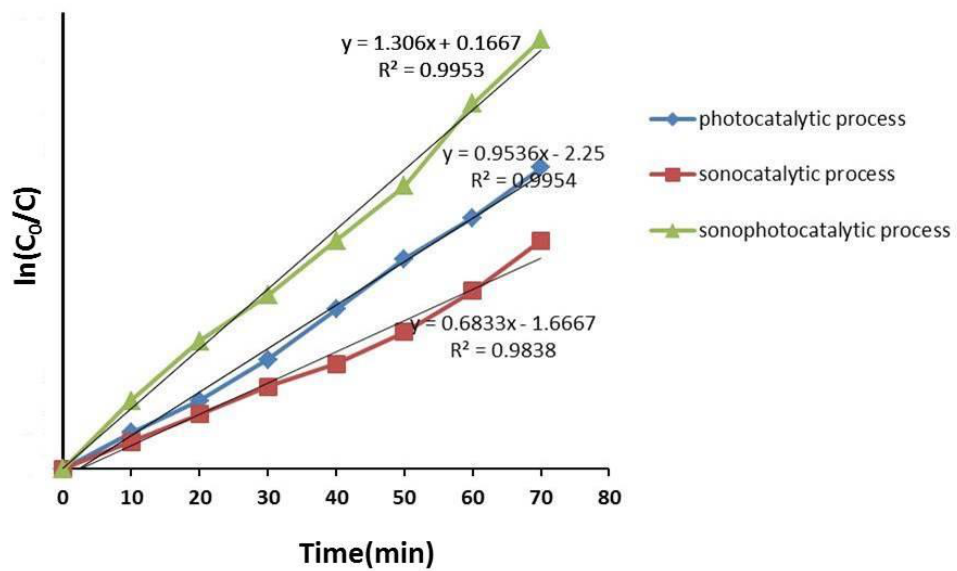
Figure 8. First-order kinetic plot for sono-photocatalytic, sonocatalytic and photocatalytic processes. [Dye] = 20 mg/L, [Catalyst] = 1.25 g/L, pH=6